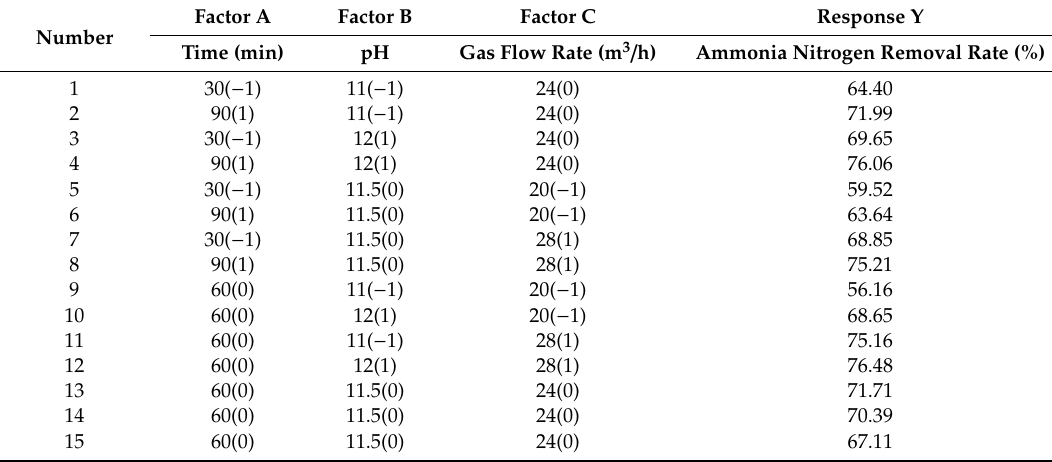
Table 3. Schemes and results of the response surface experiment.